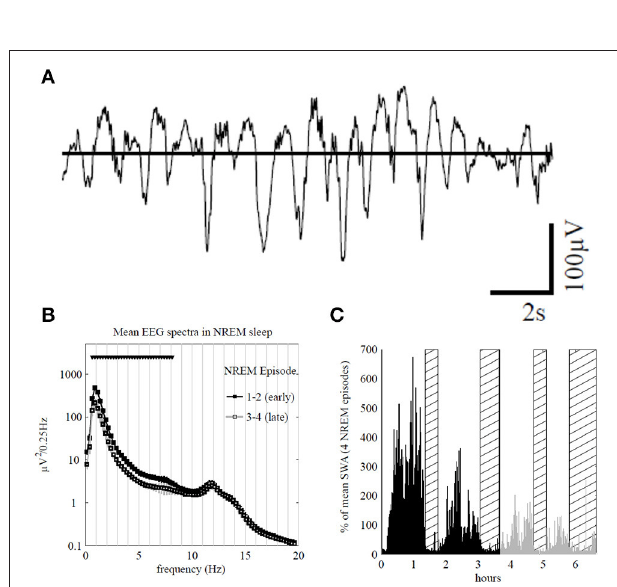
FIGURE 3 | (A) Top traces: representative 16 s electroencephalogram (EEG) traces from the Fp1 channel during early sleep. (B) Average power spectra in non-rapid eye movement (NREM) sleep during episodes 1 and 2 (early sleep, black) and episodes 3 and 4 (late sleep, gray) for Fp1 channel (mean ± SEM, n = 7 ). Triangles indicate significant bins based on SnPM ( P < 0.05, single threshold corrected). (C) Slow-wave activity (SWA; 0.5–4.0 Hz) profile in NREM sleep during the night for an individual subject (average 1-min values, % of the mean of 4 NREM episodes) rapid eye movement (REM) episodes are indicated by hatched areas. Early and late sleep (including REM episodes) are color-coded in black and gray, respectively. Note that 69% of the sleep time corresponds to NREM, 23% of REM and the rest of time refers to waking after sleep onset. In addition, about 17% of the NREM correspond to the SWS (adapted from Riedner et al., 2007, with